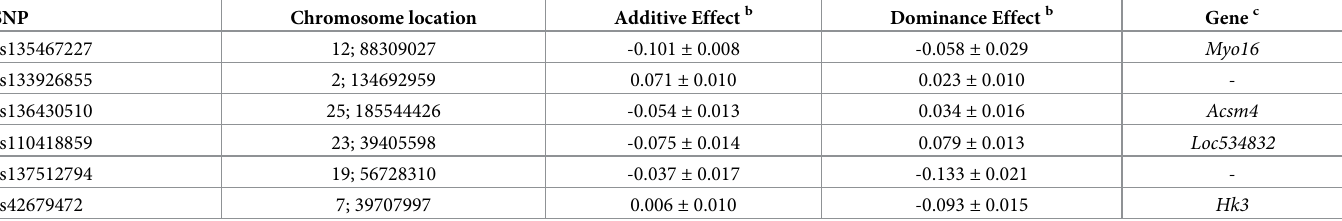
Table 4. Single nucleotide polymorphisms (SNPs) significantly associated with initial response a to E . coli O157:H7 Siderophore and Porin Receptor (SRP) protein vaccination ( n = 651 calves; Genome-Wide P < 1 x 10 −8 ). SNP